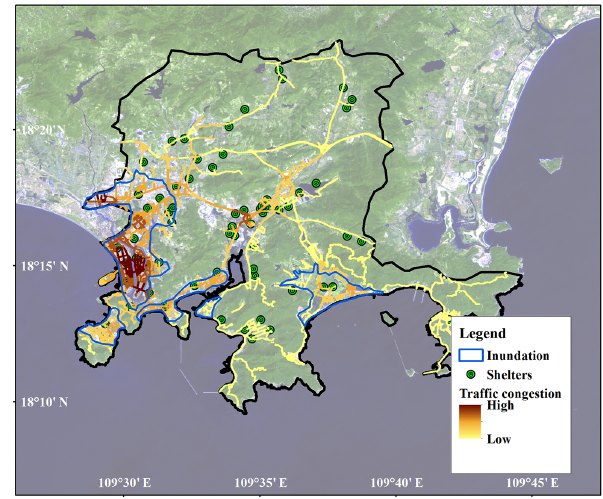
Figure 7. Evacuation cost map based on land use and slope. Figure 8. Congestion-prone roads based on population census